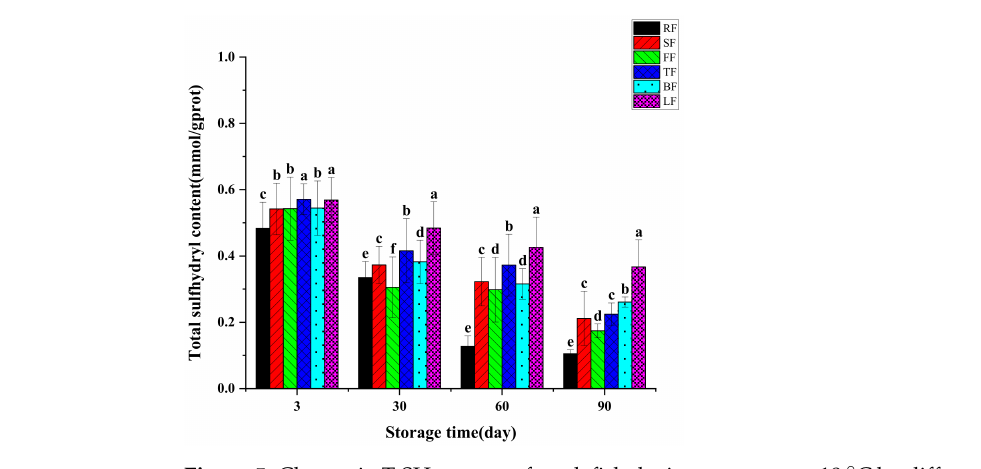
Figure 5. Change in T-SH content of cuttlefish during storage at − 18 ◦ C by different freezing methods. The letters “a–f” indicate significant differences ( p < 0.05). Error bars show standard deviation.